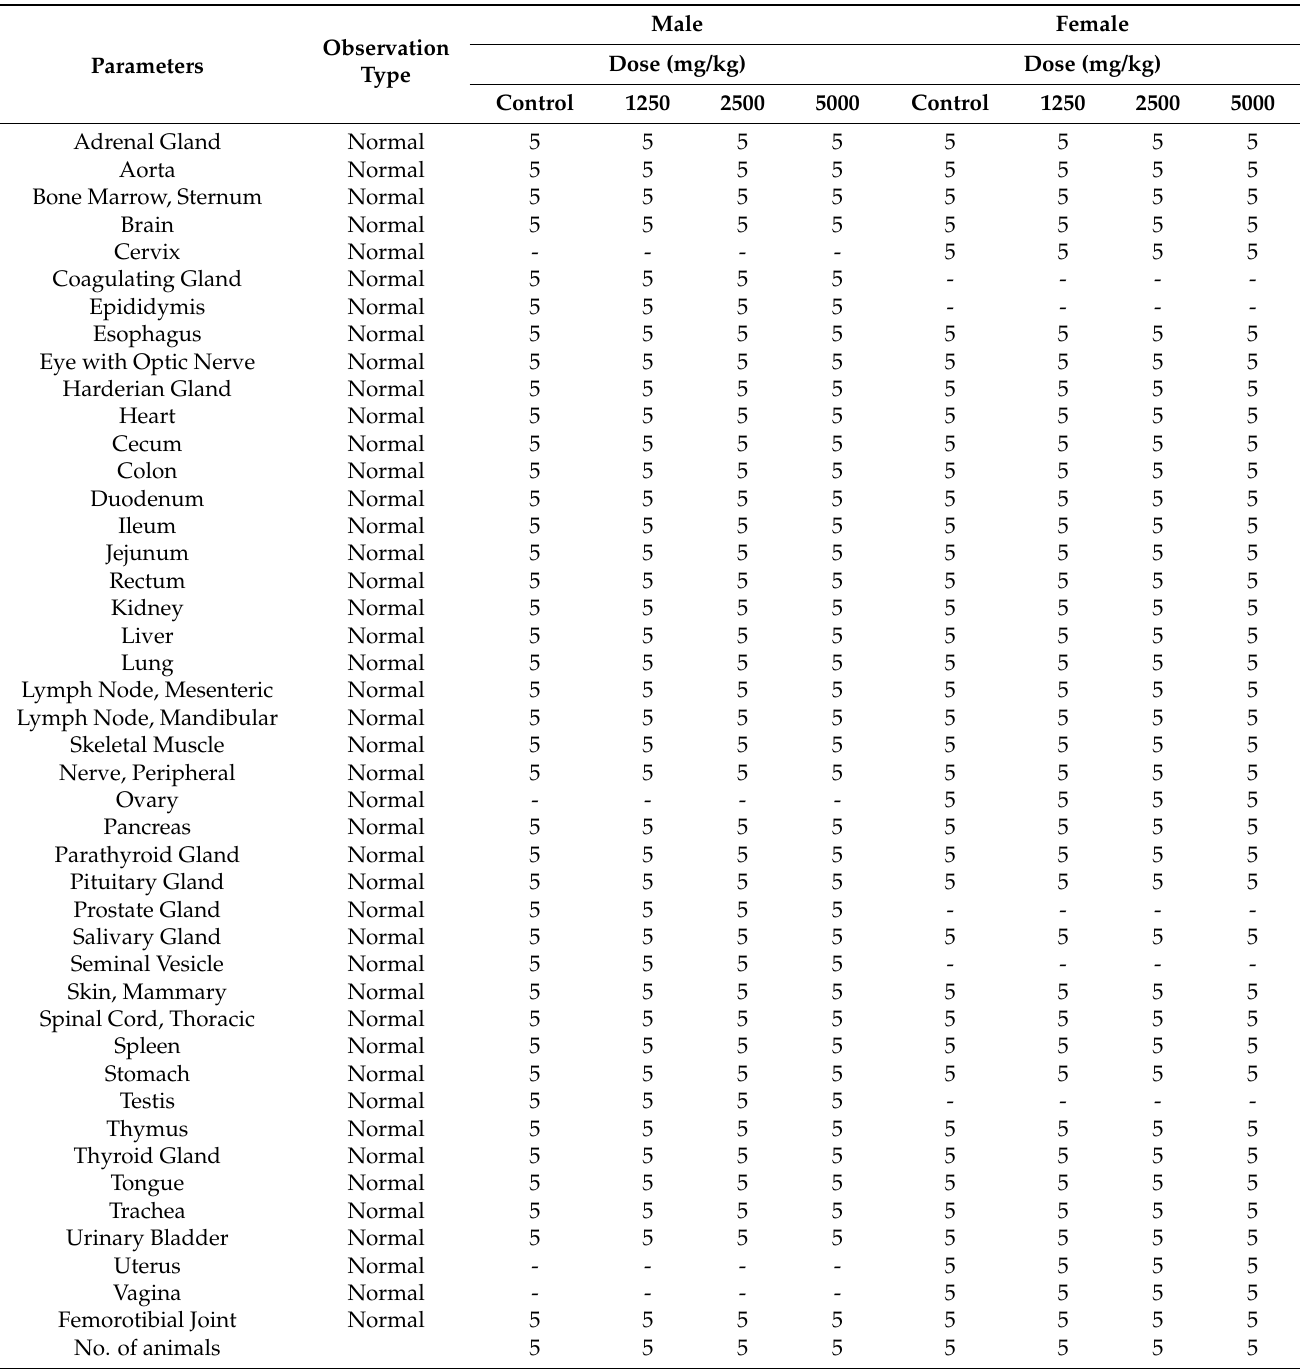
Table 3. Necropsy findings in single oral dose toxicity of WG